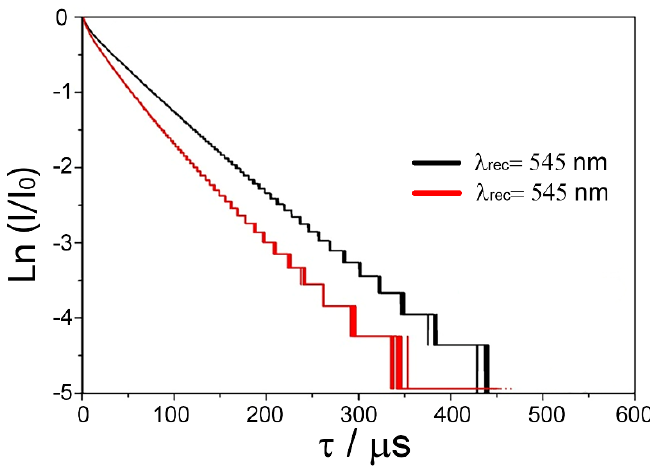
Figure 5. Luminescence extinction kinetics analysis for the 4 S 3/2 level of Er 3+ ions in the 2.5Y0.5ErSZ single crystal. single